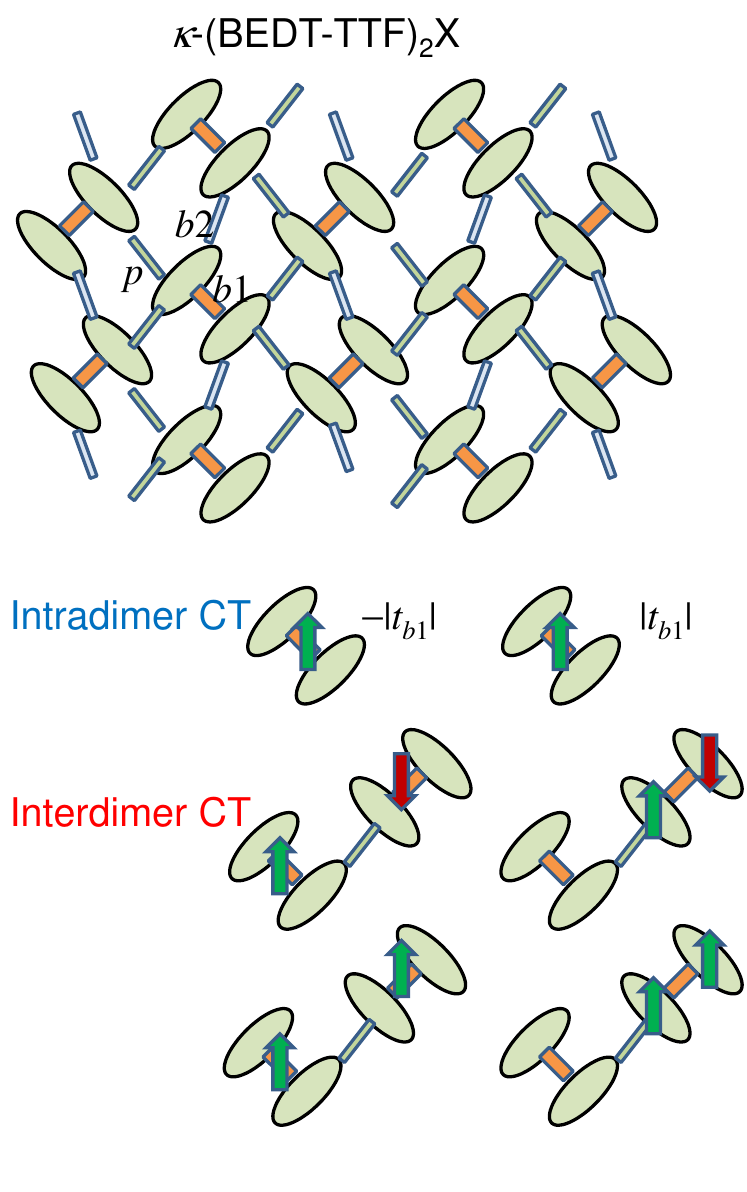
Figure 10. Schematic electronic and lattice structures of κ -(BEDT-TTF) and interdimer charge-transfer excitation